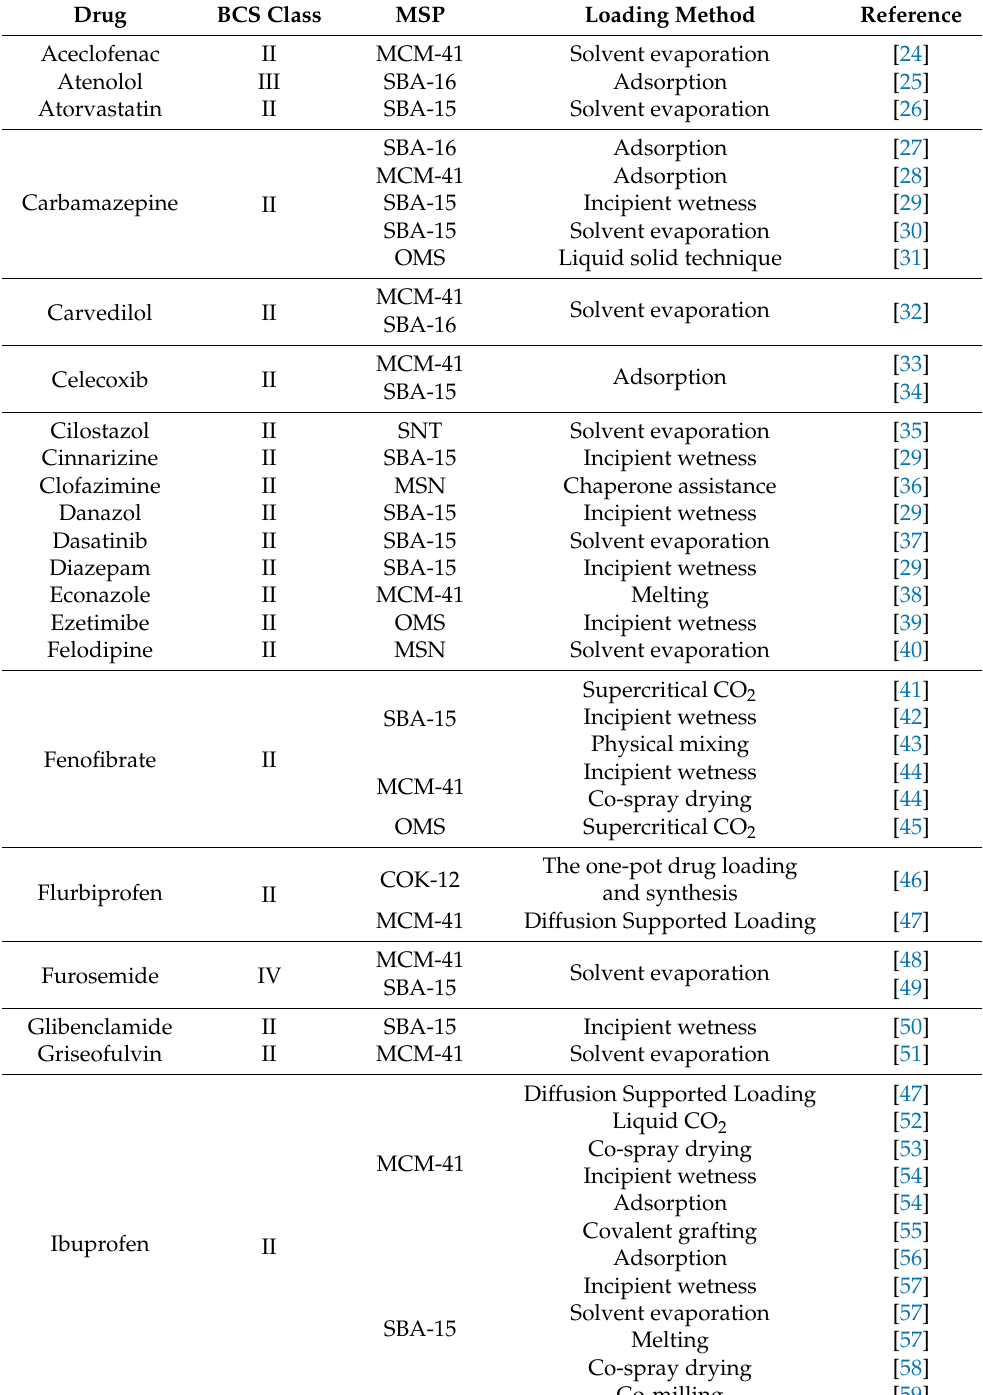
Table 1. Review of drug loading methods used, drug type, and mesoporous silicas in published